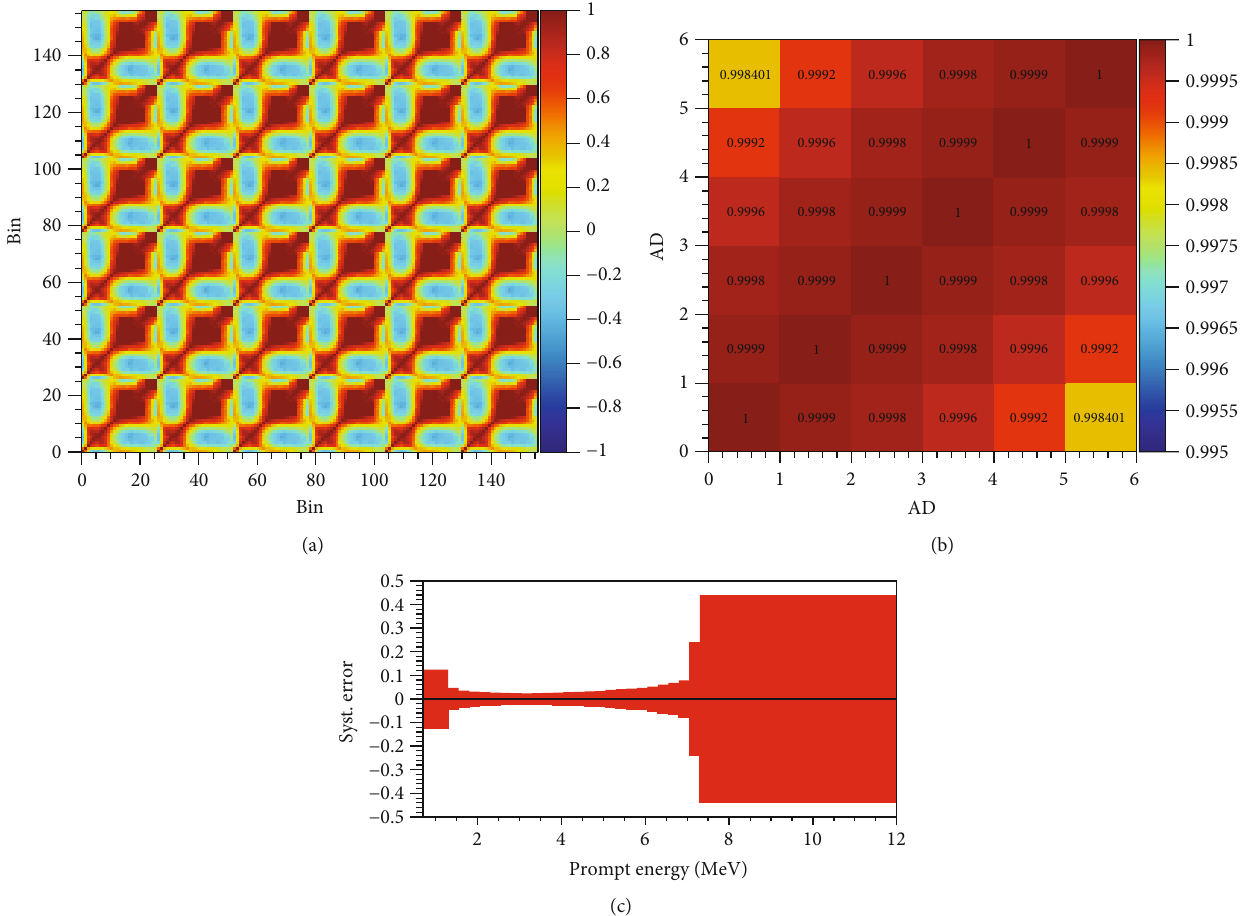
Figure 6: (a) Full systematic error (signal, background, and reactor cores) correlation matrix used in the Daya Bay analysis with 26 bins per AD (signal, backgrounds, and reactor cores). Each square block represents the correlation among the bins of two ADs. (b) Correlation matrix for the 6 ADs. (c) Total fractional systematic uncertainties in the prompt energy distribution, assumed equal for all